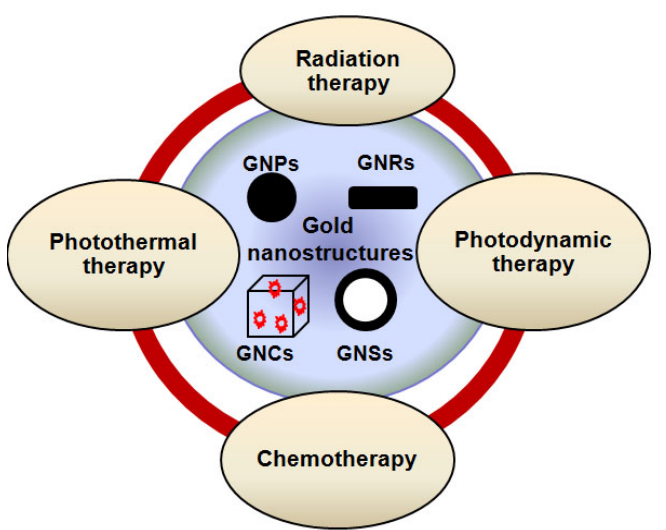
Figure 1. TEM images and optical properties of different sized and shaped gold nanostructures: spherical GNPs (top left), GNRs (top right), GNCs (bottom left), and GNS (bottom right), respectively. Reproduced with permission